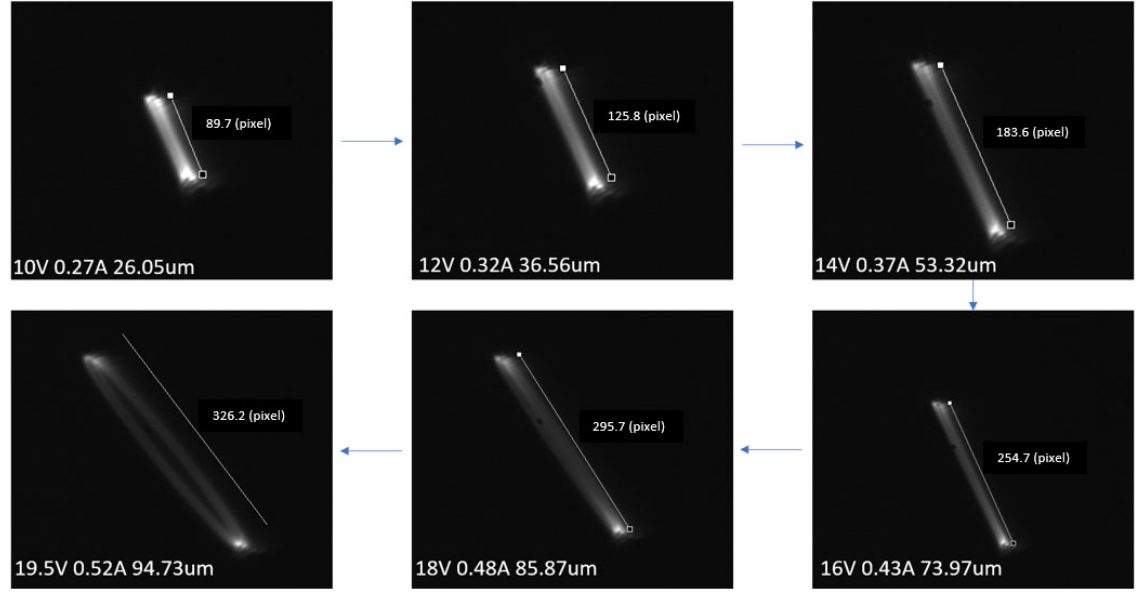
Figure 6. The tip displacement as a function of current.